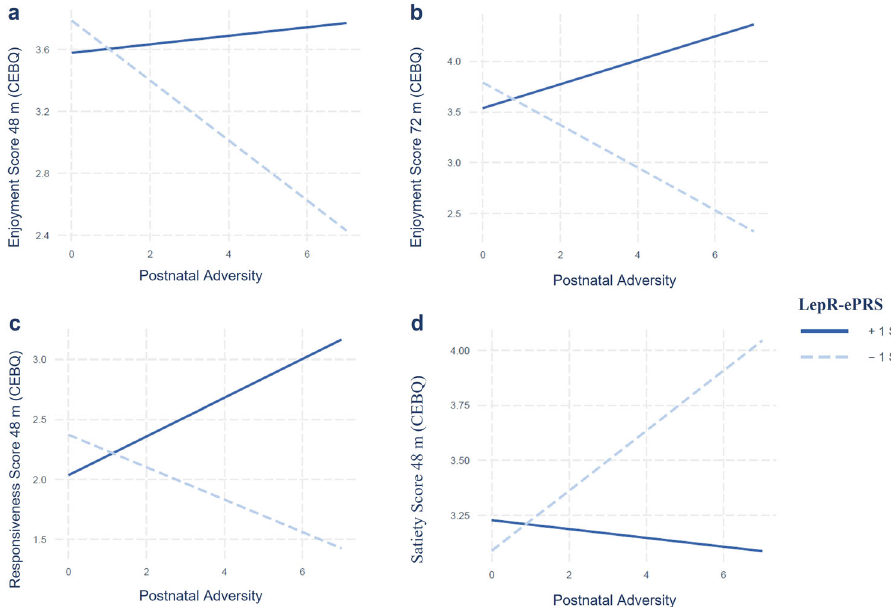
Fig. 1 Interaction effect between the Postnatal Adversity Score and Prefrontal-based LepR-ePRS in the MAVAN cohort. Interaction effect between the Postnatal Adversity Score and Prefrontal-based LepR-ePRS on: a ) Enjoyment score at 48 and b ) 72 months, c ) Food responsiveness score at 48 months and d ) Satiety score at 48 months. Increased postnatal adversity exposure is associated with higher satiety and lower food enjoyment as the ePRS decreases, and with higherFoodresponsivenessas the ePRSincreases. MAVANcohort(48m N = 133, 72m N = 129). Linear regressionanalysesfollowedby simple